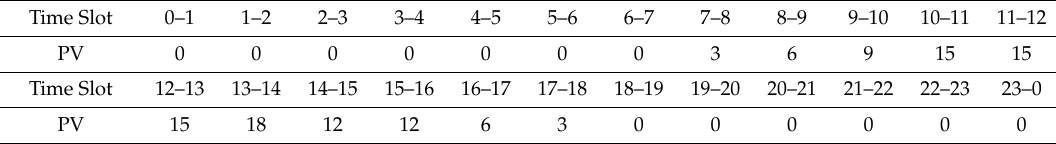
Table 6. The predicted values of power supply schedule.